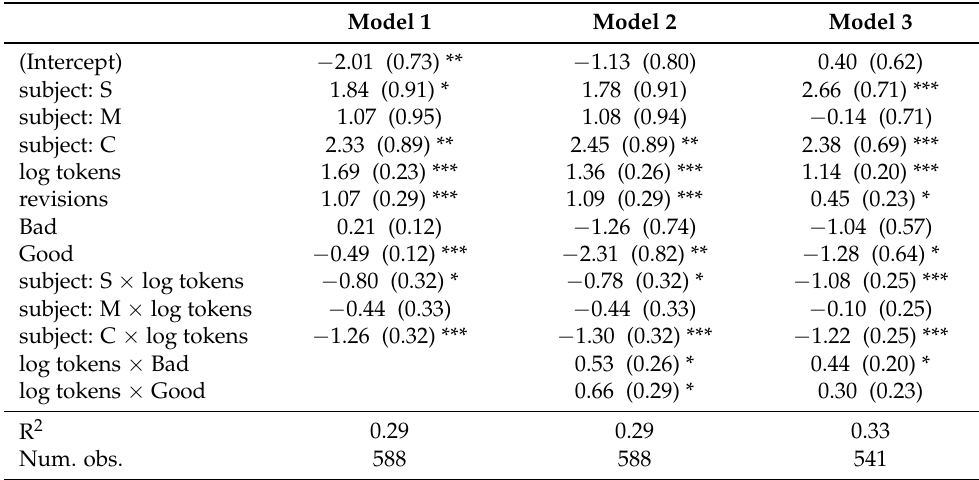
Table 7. Models for post-editing keystroke count. Model 3 removes all observations where no keystrokes were recorded.